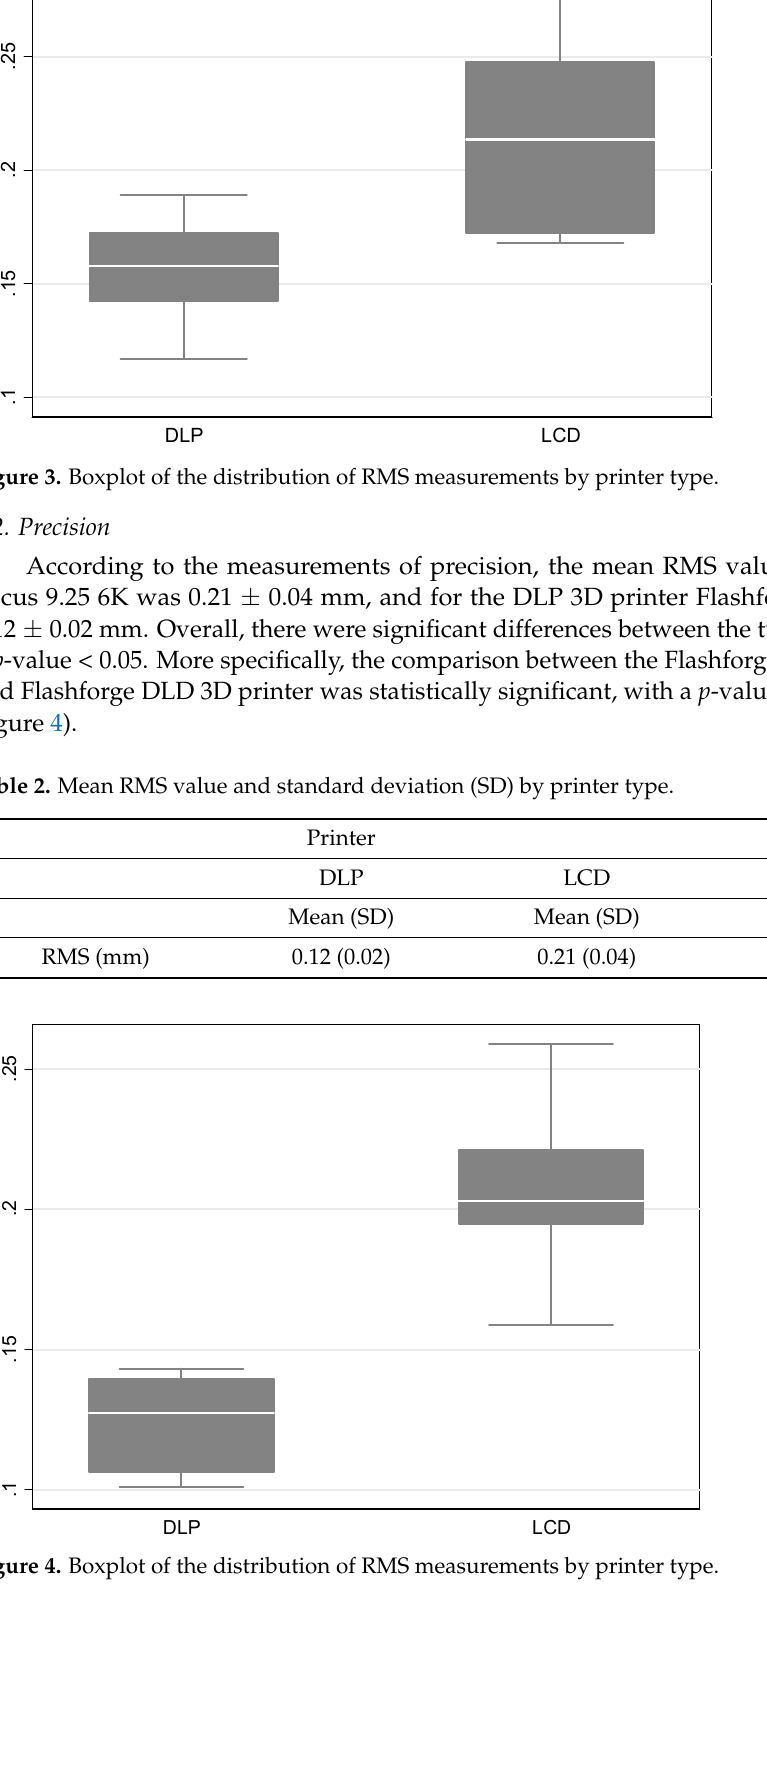
Figure 4. Boxplot of the distribution of RMS measurements by printer type.